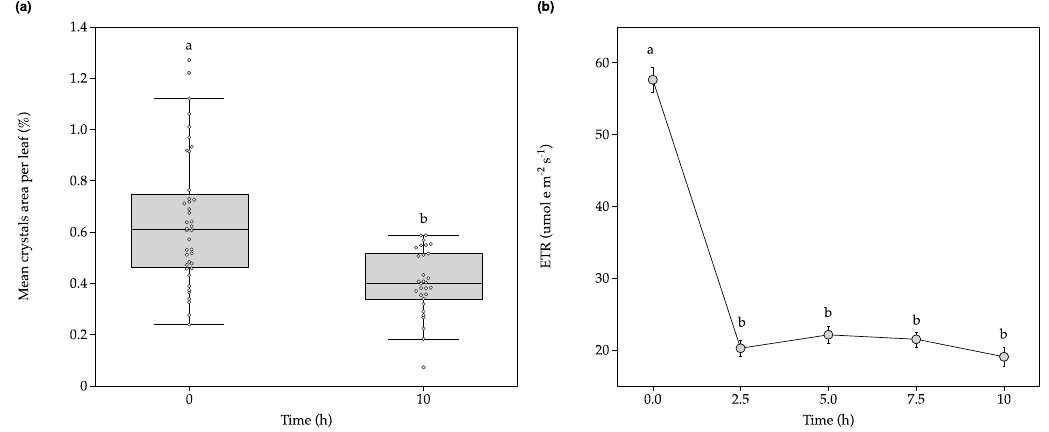
Figure 4. Fluctuations in total mean crystals area per leaf ( a ); and electron transport rate (ETR) ( b ) of C. quitensis plants under non ‐ photorespiratory conditions (100% N 2 ). Plants were kept over time under constant light in airtight chambers injected with N 2 100%. In (a), the horizontal line indicates the mean and length of each whisker indicates the interquartile range (IQR); n = 35; different letters represent statistically significant differences (Independent samples t ‐ test, p < 0.01). In ( b ), error bars denote SE of mean; n = 15. Different letters represent statistically significant differences between time (One ‐ way ANOVA; p < 0.05).